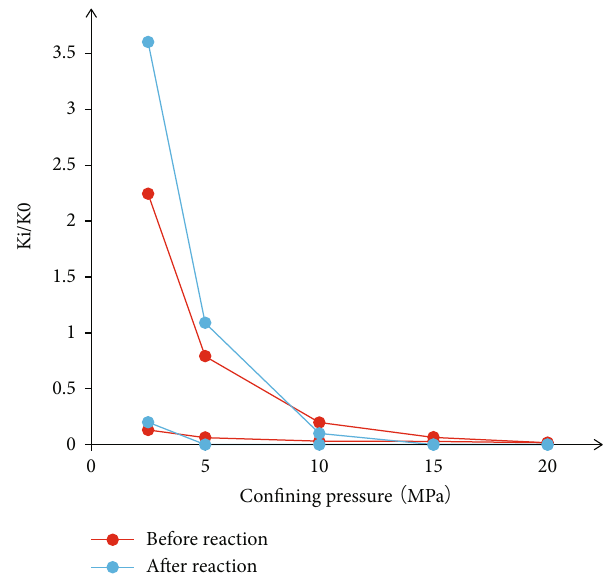
Figure 12: Stress sensitivity of shale before and after interaction with 5000mg/L NaCl solution for 6 h.